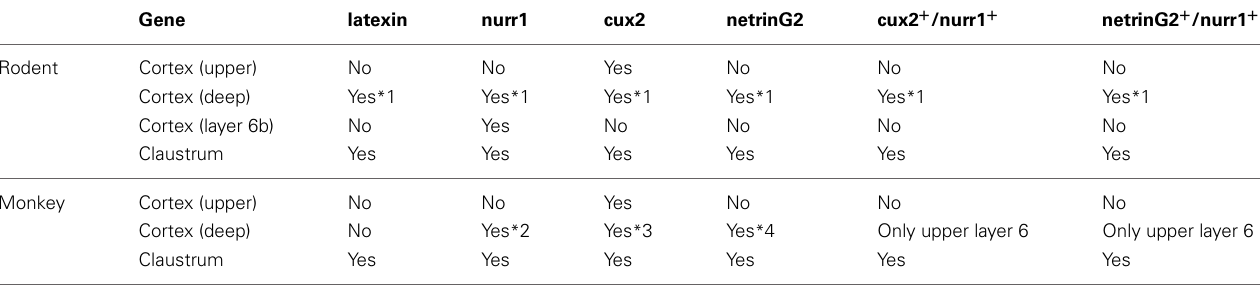
Monkey Cortex (upper) Cortex